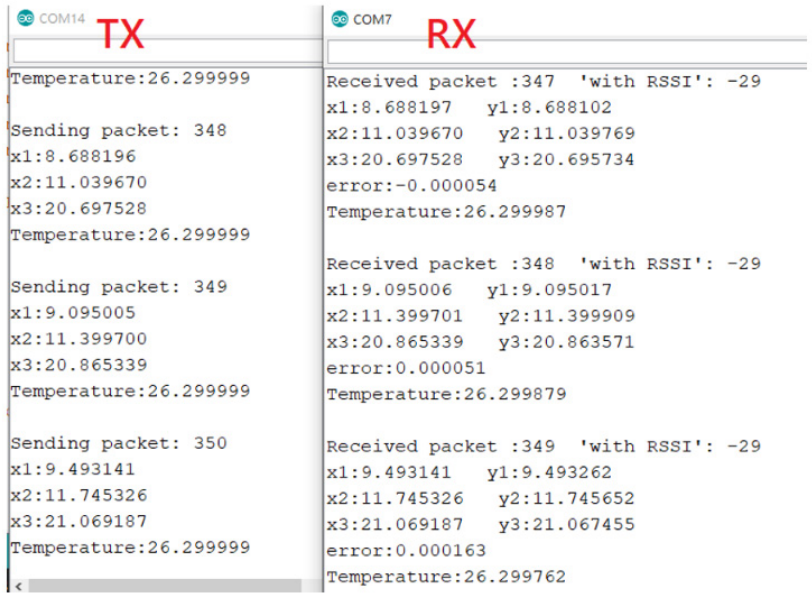
Figure 18. The result of implementing a chaotic encryption system.